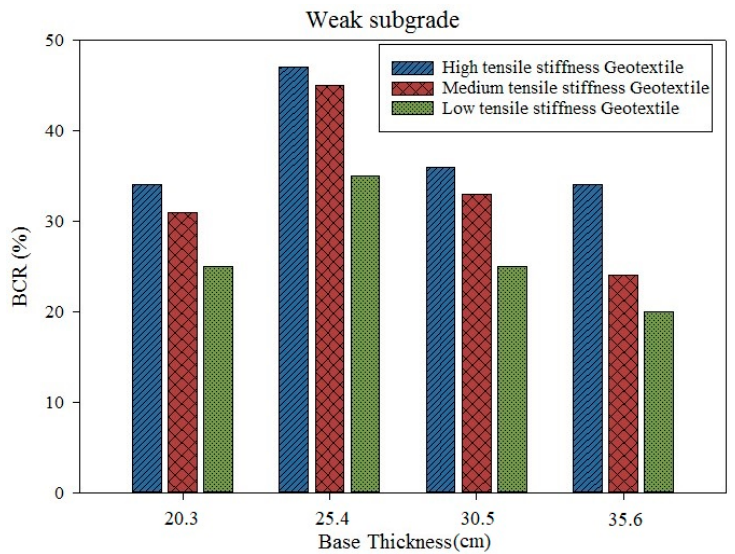
Figure 17. Changes in the BCR of the pavement reinforced with a geotextile on weak subgrade soil for different geosynthetic